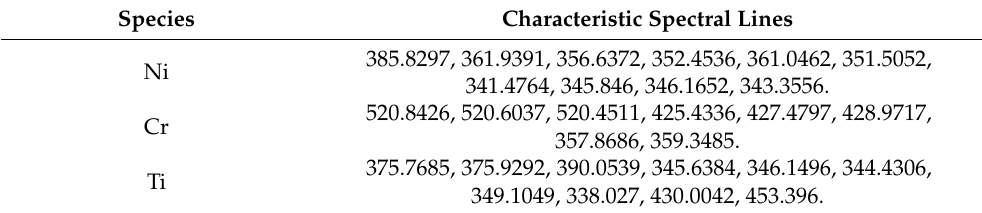
Table 4. Selection of characteristic spectral lines without Pearson correlation